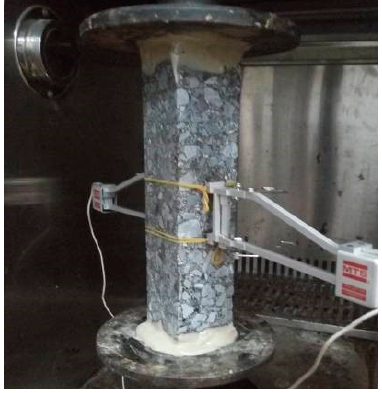
Figure 1. The process of direct tensile test.